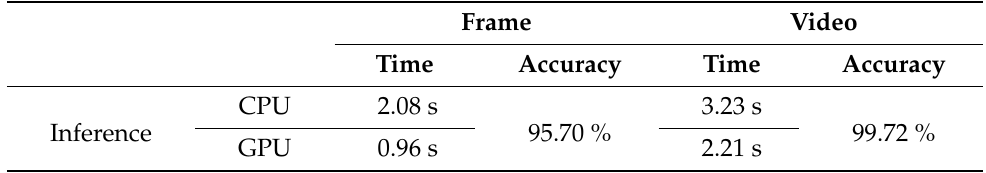
Table 1. Overall computational cost.